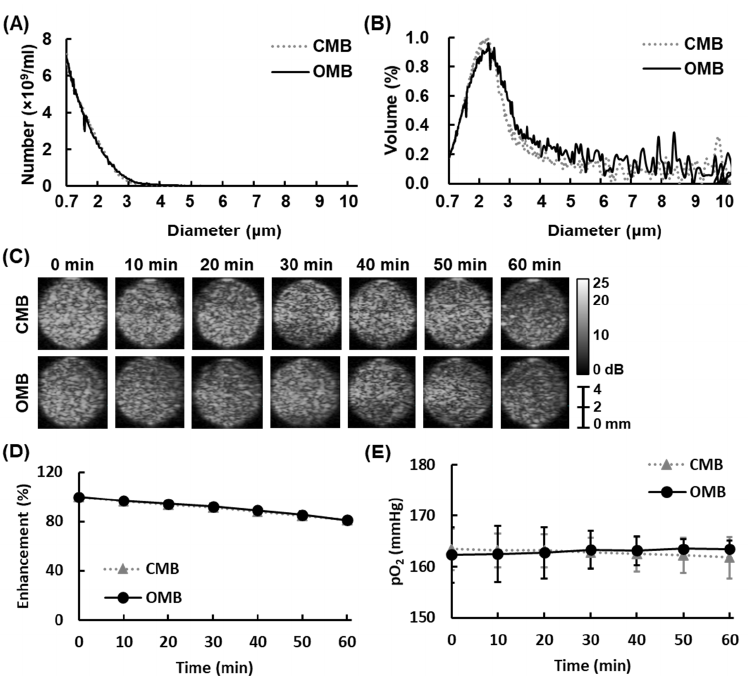
Figure 3. Characterization of OMBs. The size distribution of OMBs according to the ( A ) number and ( B ) volume percentage. Evaluation of OMB stability by ( C ) US imaging, ( D ) the corresponding quantification data, and ( E ) the pO 2 level.